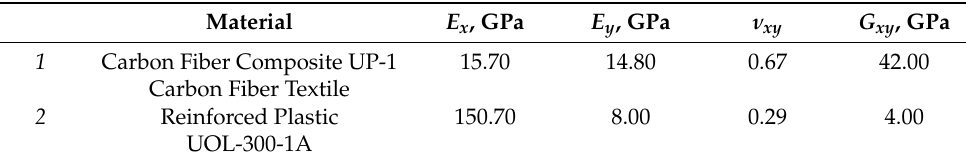
Table 1. Material properties of some orthotropic composites [38].